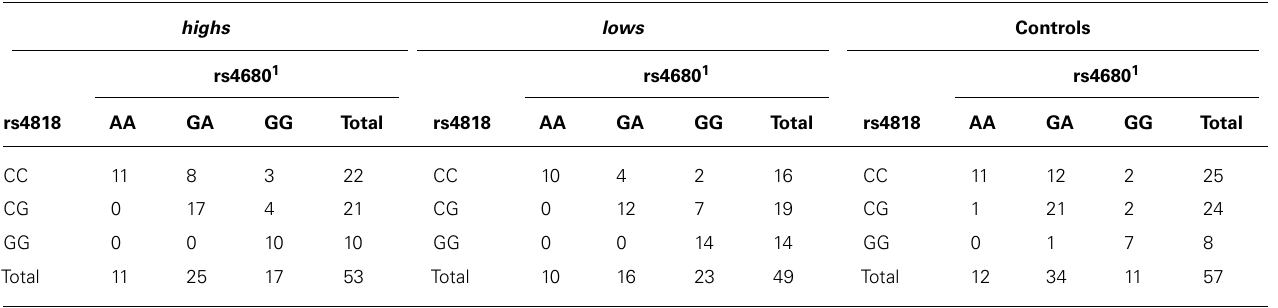
Table 2 | Joint genotype distribution of rs4818 (C/G, or Leu 136 Leu) and rs4680 (G/A, orVal 158 Met), in three population samples.